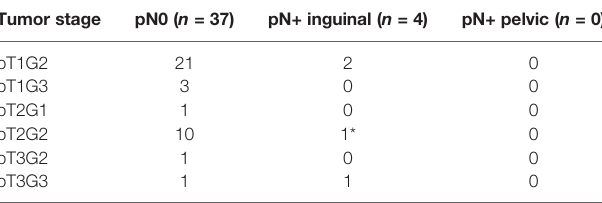
TABLE 2 | Histopathological results of